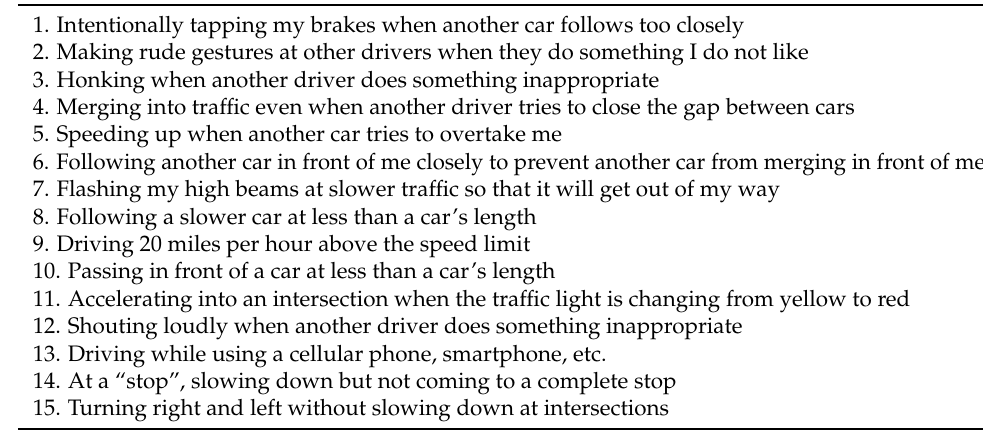
Table 1. Questionnaire on moral values for driving behavior.